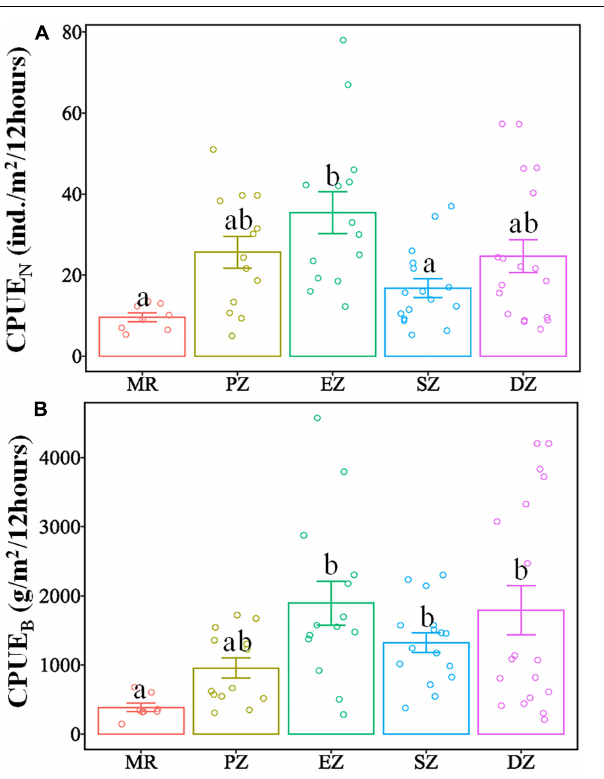
River to the outlet of Lake Yanlong were distinctly